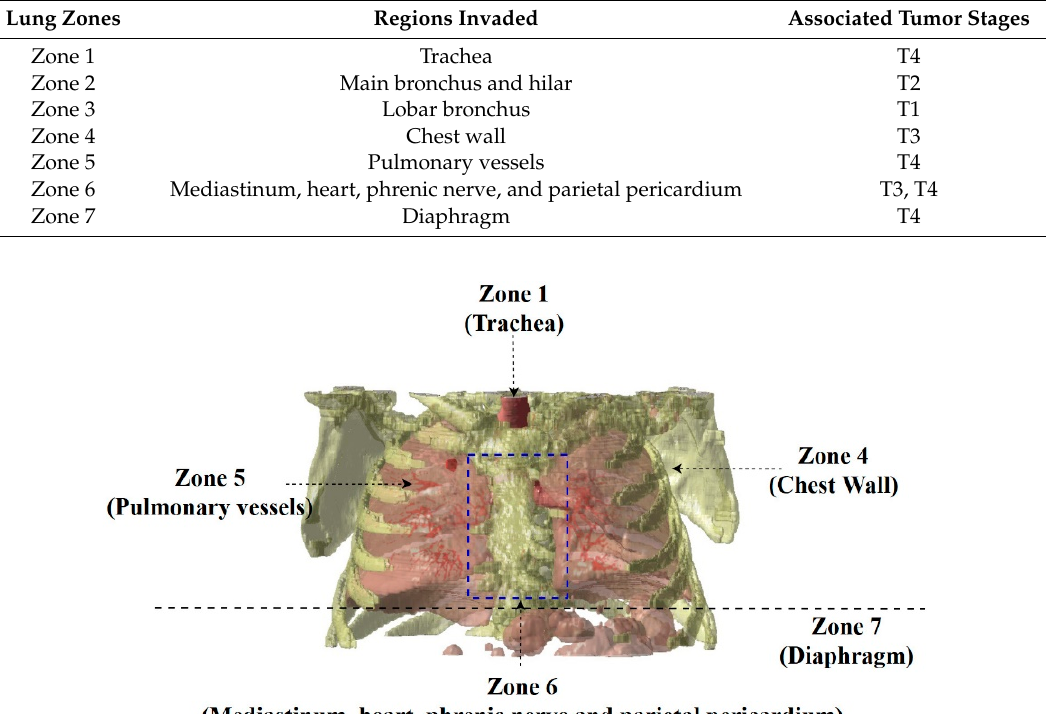
Table 2. Dividing different zones.